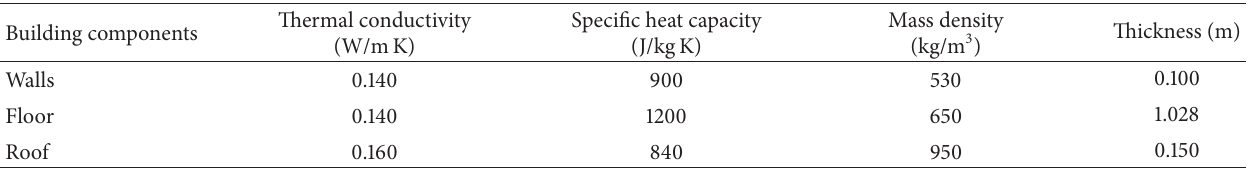
Figure 9: A two-thermal-zone Revit model with two windows and a door. (a) Floor-plan and isometric views. (b) The custom parameter window for adding additional physical properties for the glazing system. Table 3: Material